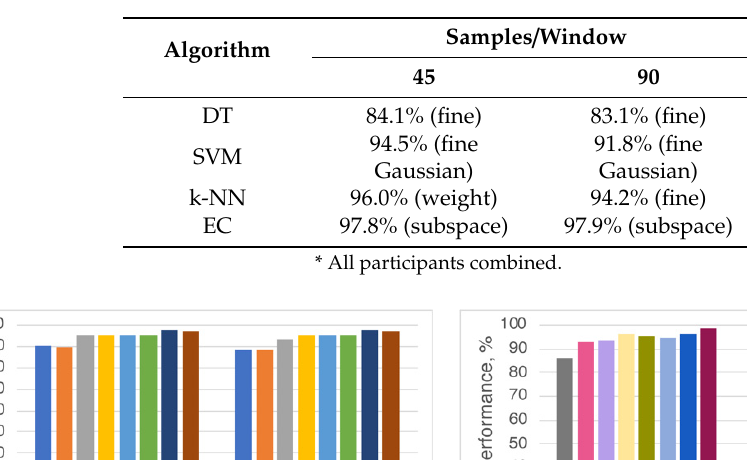
Table 2. Accuracy performance of the algorithms classifying early and late fatigue phases *.